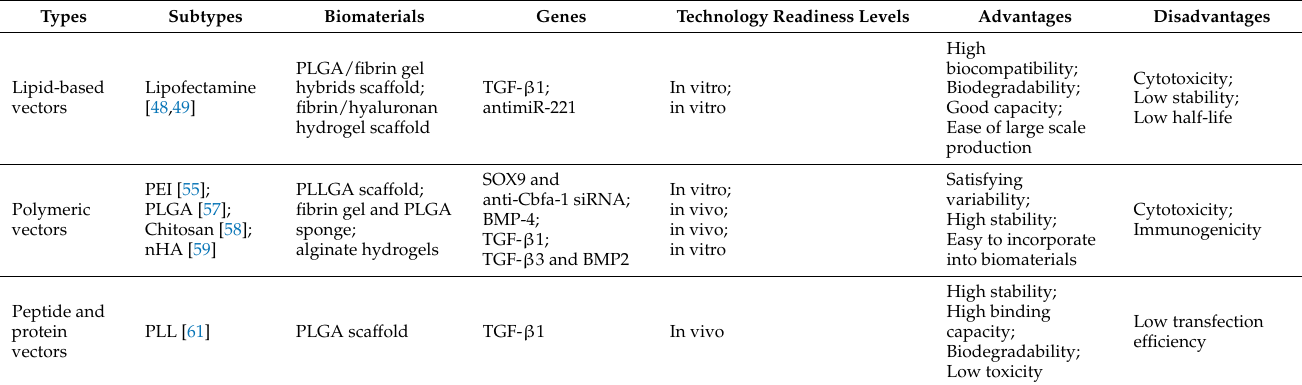
Table 2. A comparison of different non-viral gene delivery systems used in biomaterial-mediated gene